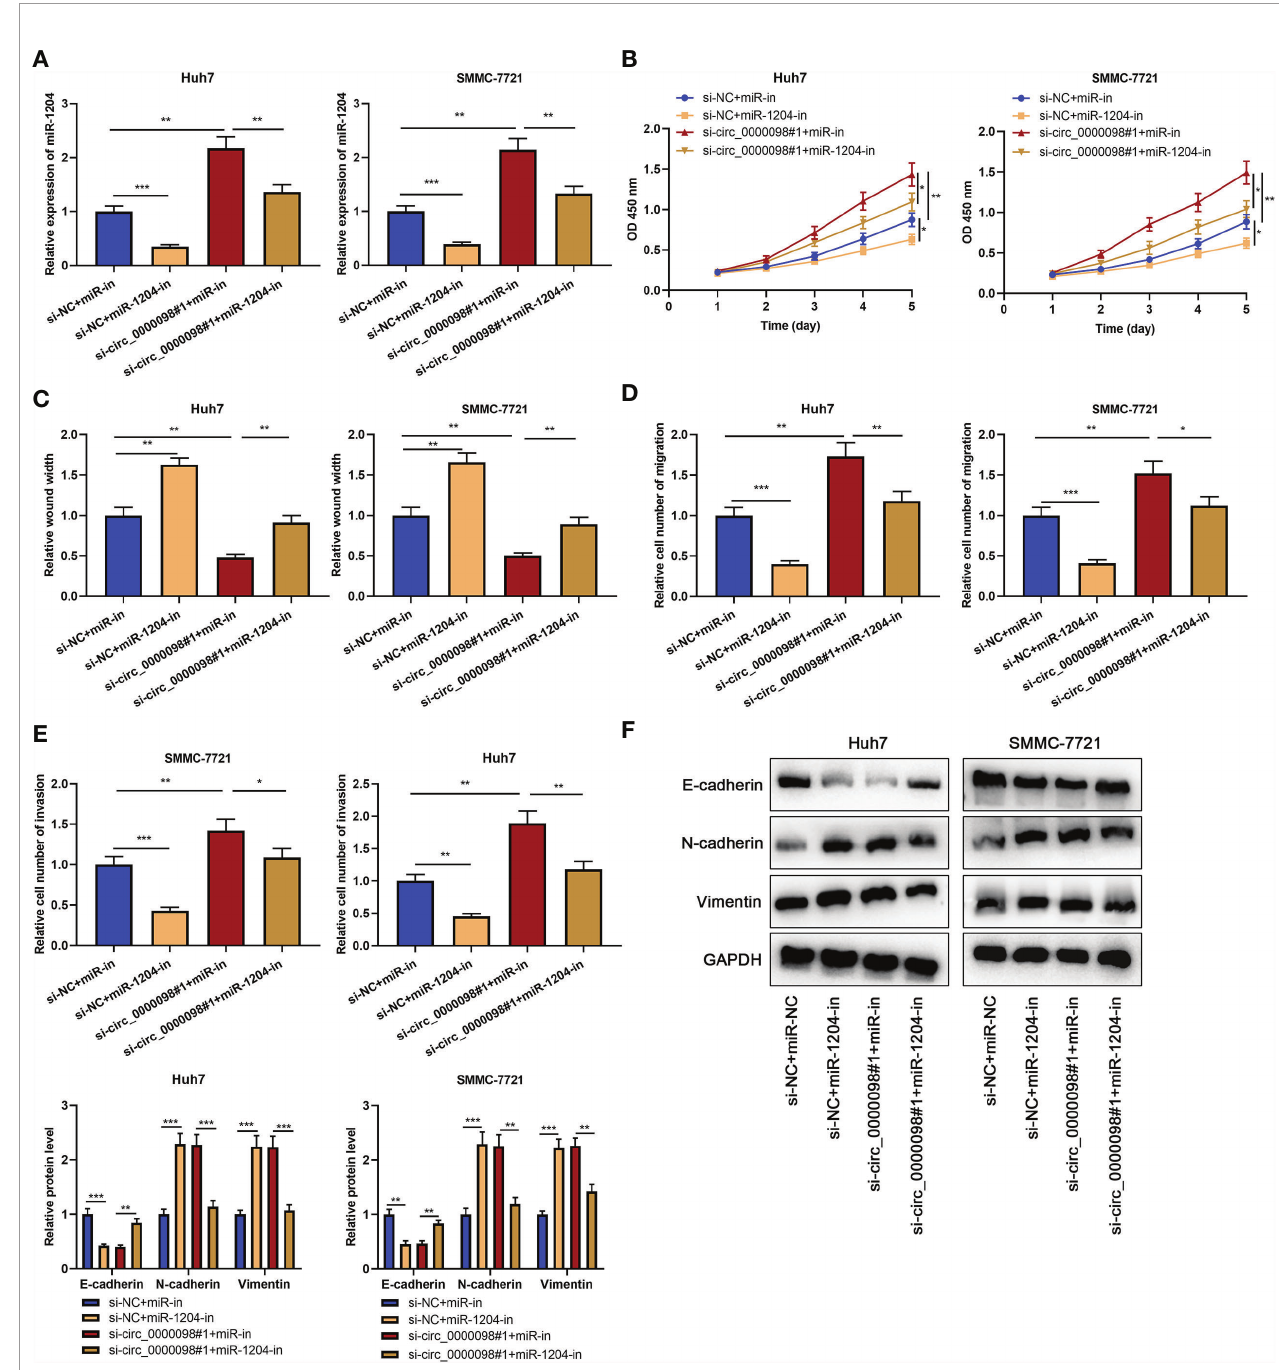
FIGURE 4 | Circ_0000098 regulated the progression of HCC by adsorbing miR-1204. HCC cells were transfected with si-NC+miR-in, si-NC+miR-1204-in, si- circ_0000098#1+miR-in, or si-circ_0000098#1+miR-1204-in. (A) The expression of miR-1204 in Huh7 and SMMC-7721 cells was detected by qRT-PCR. (B) The cell proliferation was detected by CCK-8 assay. (C) The migration ability of cells was detected by wound healing assay. (D, E) Transwell assay was used to detect cell migration and invasion. (F) Western blot assay was used to detect the expression levels of E-cadherin, N-cadherin, and Vimentin in Huh7 and SMMC-7721 cells. * P < 0.05, ** P < 0.01, and *** P <